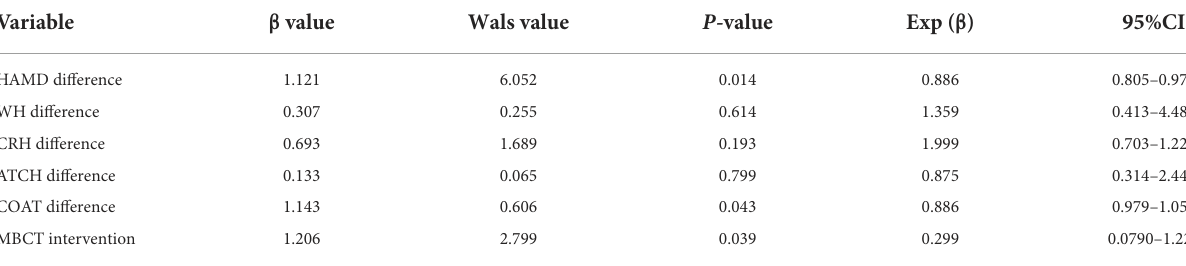
TABLE 4 Analysis of related influencing factors of depression